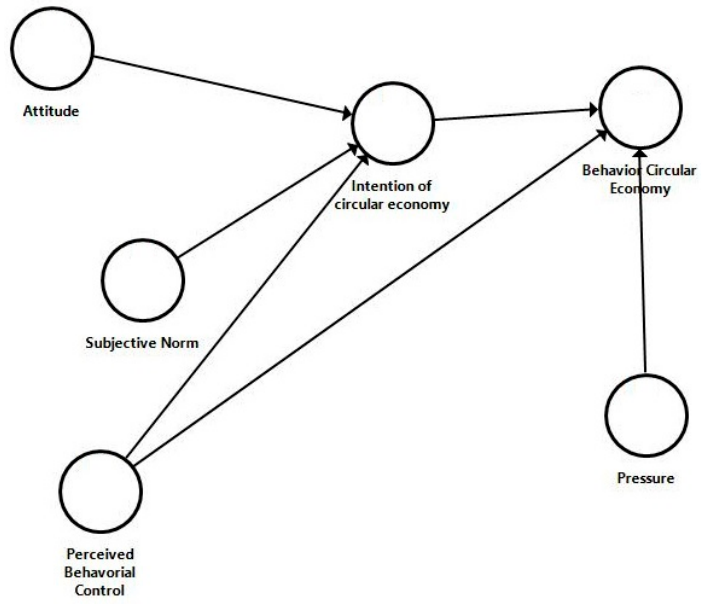
Figure 1. Research model.